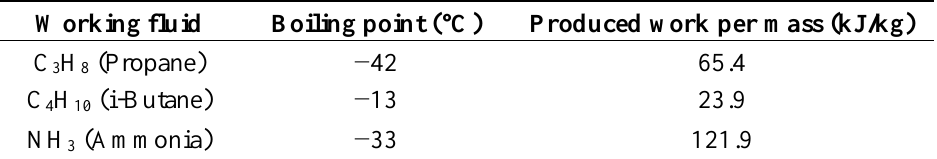
Table 1. Characteristics of the working